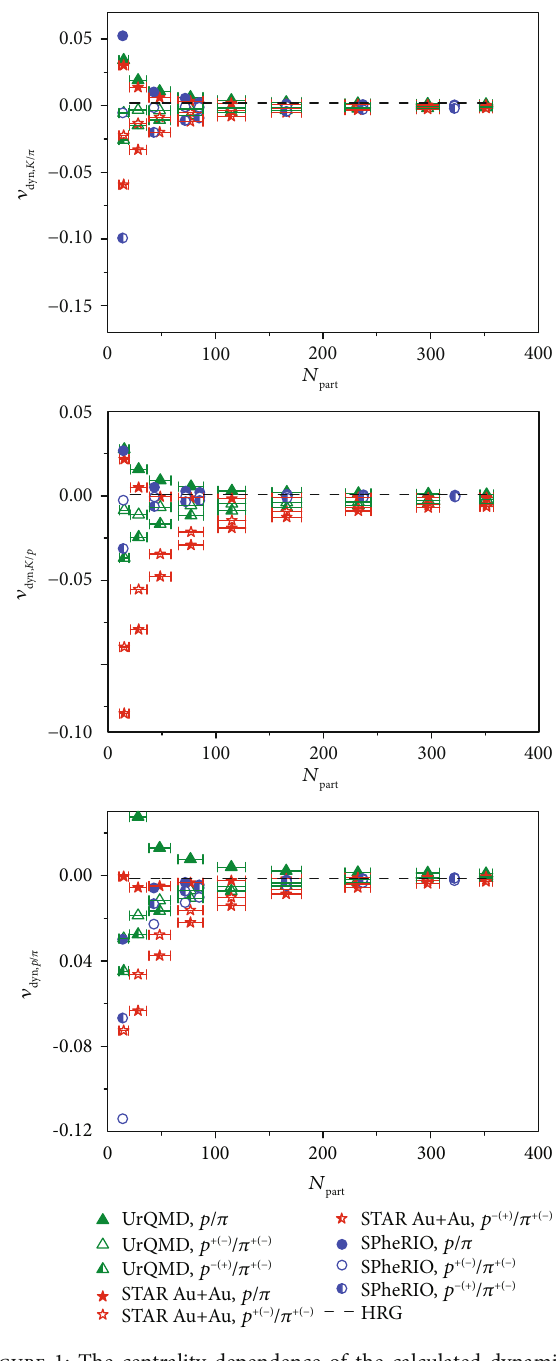
Figure 1: The centrality dependence of the calculated dynamical fl uctuations of particle ratio K / π , p / π , and K / p for Au+Au collisions at 200 GeV. The STAR data are from Ref. [26], presented by fi lled, open, half- fi lled red stars. The SPheRIO results are given by the fi lled, open, half- fi lled blue circle. The UrQMD model calculations are shown in the fi lled, open, half- fi lled green triangle. The dashed black line presents the HRG